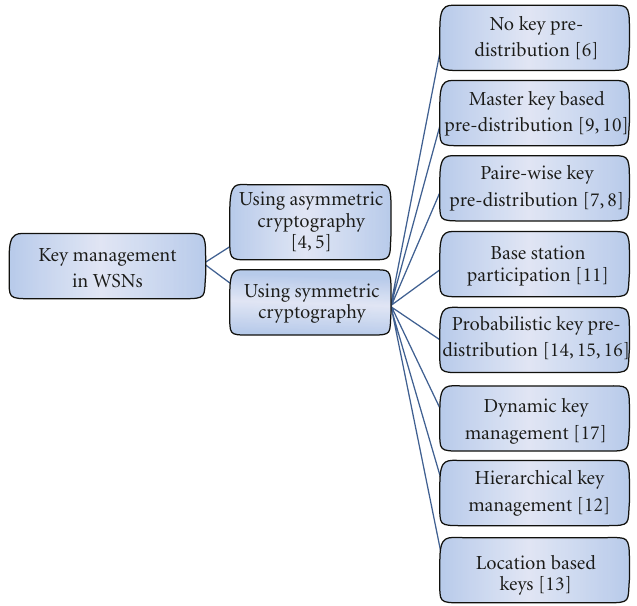
Figure 2: Existing key management solutions for